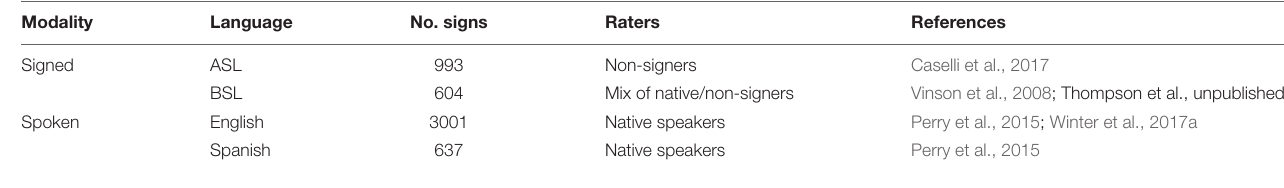
TABLE 1 | Source of iconicity ratings for each